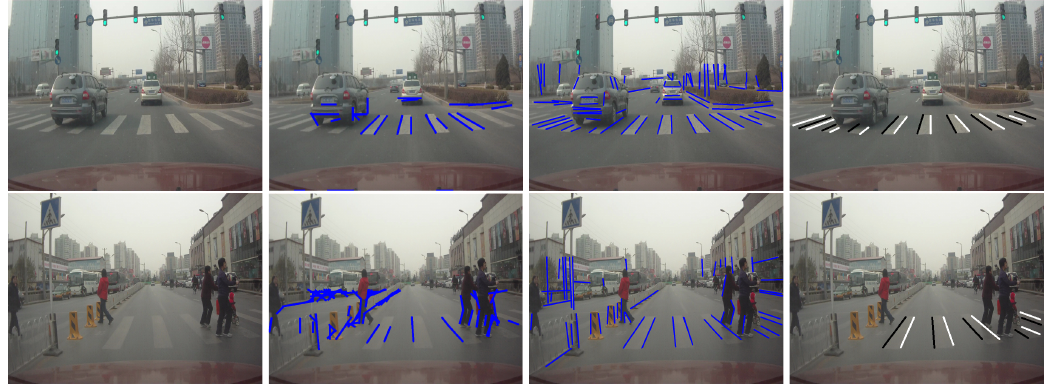
Figure 5. Examples of line feature detection results using traditional HT, improved HT, and edge partition based on improved HT. (First column: original image; Second column: line extraction results using tradition HT; Third column: line feature detection using improved HT; Forth column: edge partition results based on improved